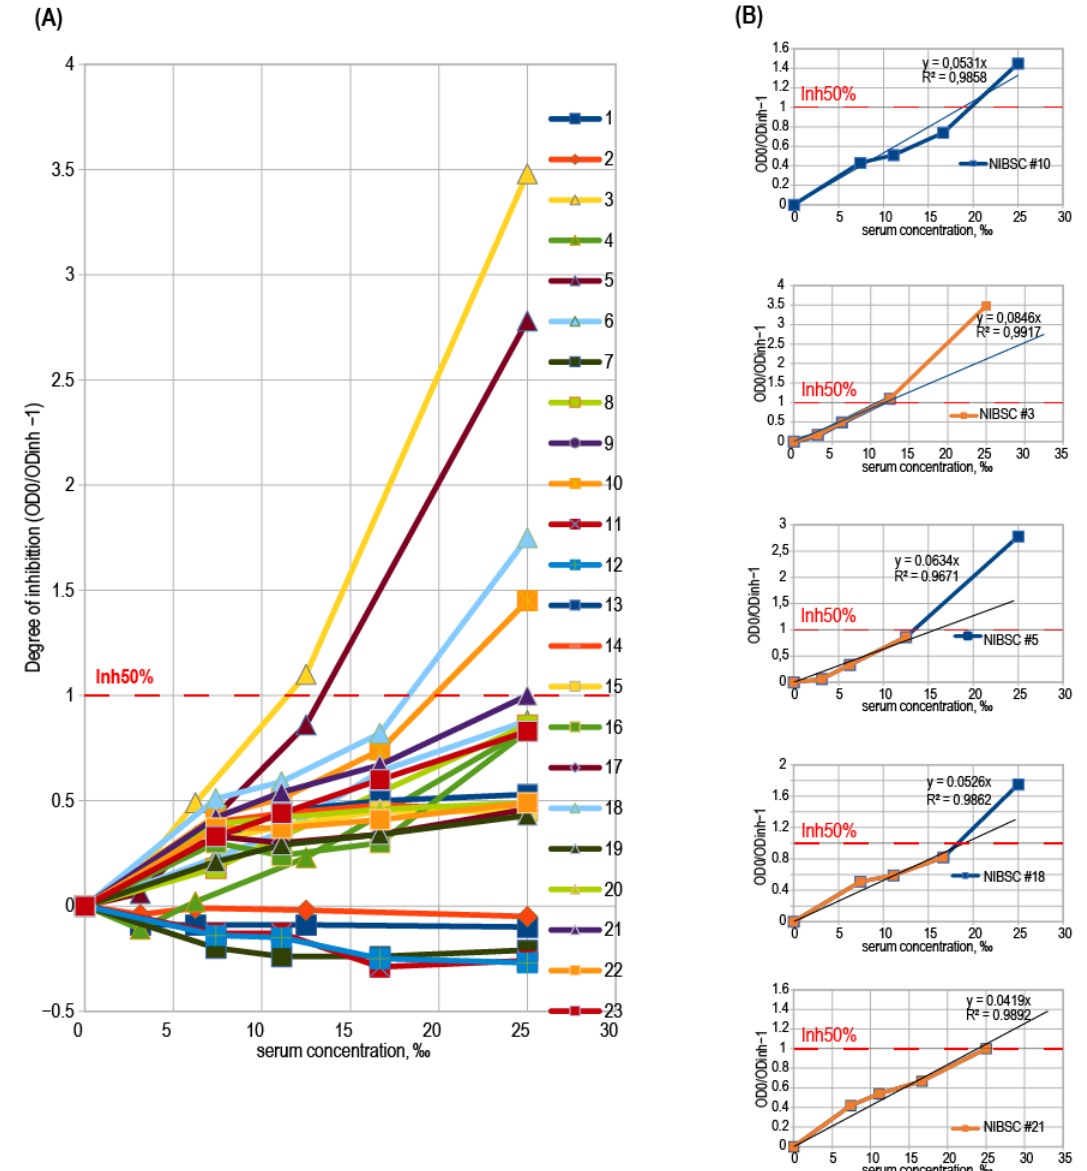
Figure A4. Concentration—inhibition relationship plots for sVNT; positive samples from the NIBSC control panel. ( A ) Composite plot; ( B ) Five individual plots with the linear curve approximation for test samples with highest inhibitory properties.